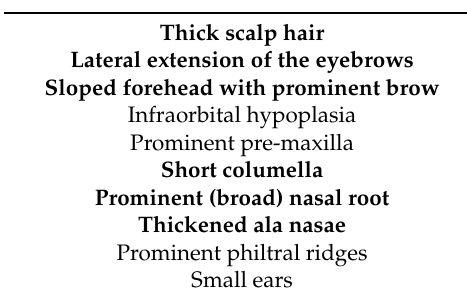
Table 4. Common Facial Features Noted in Non-syndromic ASD